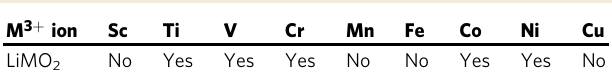
Table 1 LiMO 2 oxides crystallizing in the O3 layered structure of LiCoO 2